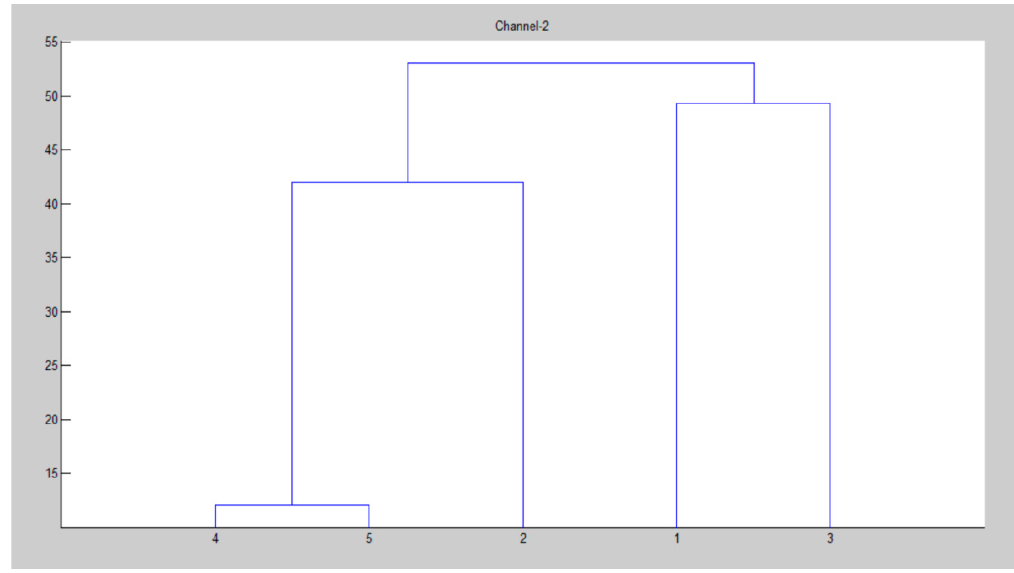
Figure 9. Channel 2 grouping.